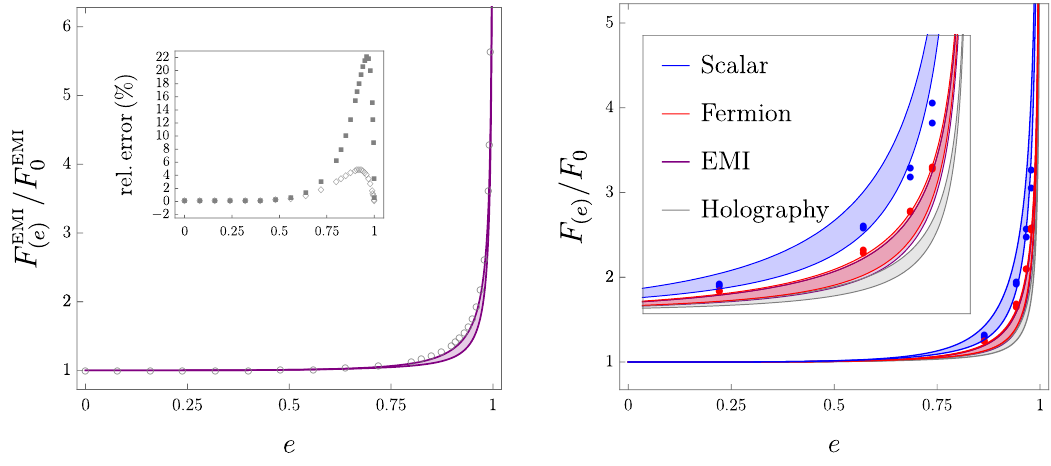
Figure 2 . We plot the universal contribution to the entanglement entropy corresponding to an elliptic region, normalized by the disk result, F 0 , as a function of the eccentricity. In the left plot, the data points are (exact) numerical results obtained for the EMI model and the purple curves are the trial functions F | trial 1 , 2 particularized to this model. The relative error in the approximations ( e ) is shown in the inset. In the right plot, we present both trial-function curves for: a free scalar, a free fermion, the EMI model and holographic Einstein gravity. The dots correspond to lattice values for the scalar and the fermion. The inset is a zoom in of the region e > 0 . 85